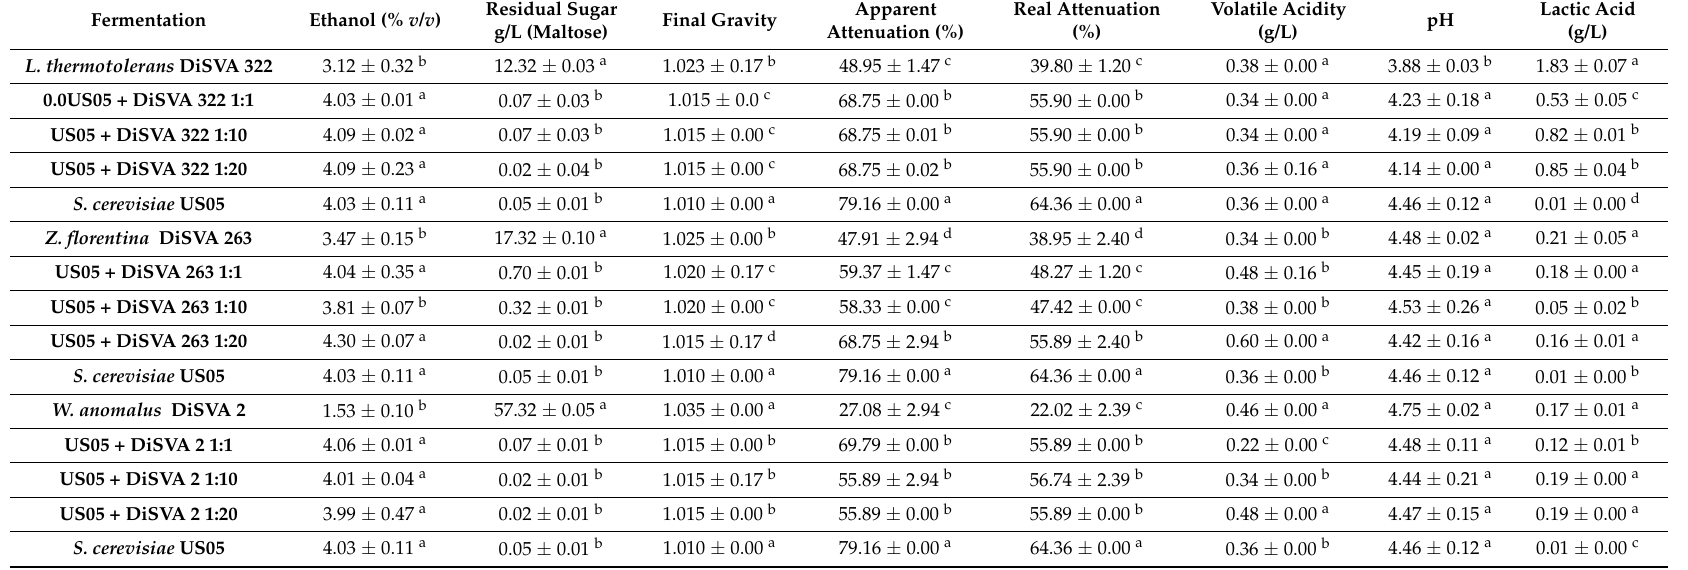
Table 2. The main analytical characteristics of the beer produced by the pure and mixed